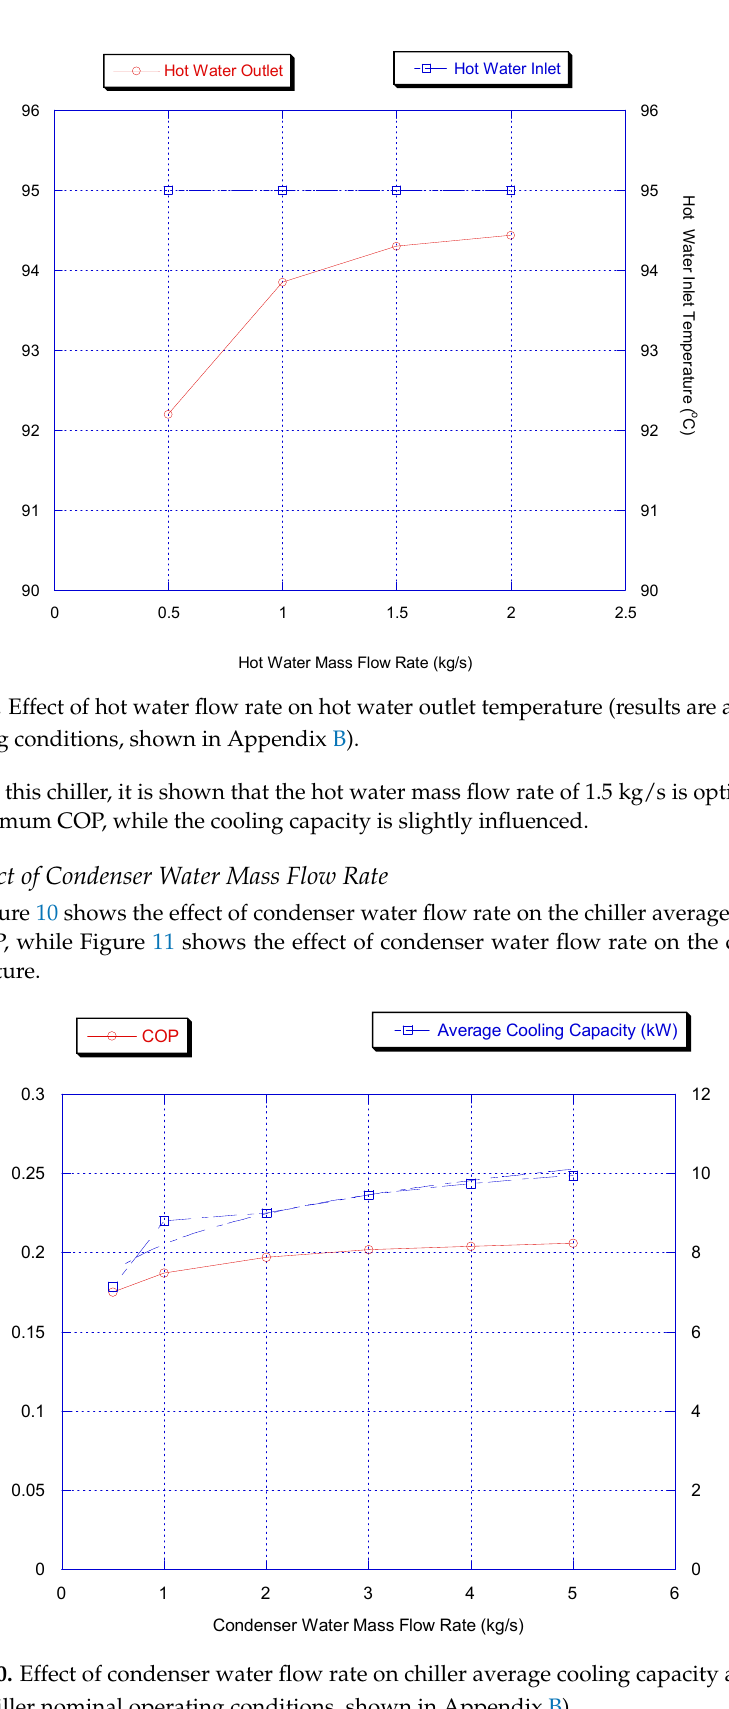
Figure 8. Effect of hot water flow rate on chiller average cooling capacity and COP (results are at chiller nominal operating conditions, shown in Appendix B).